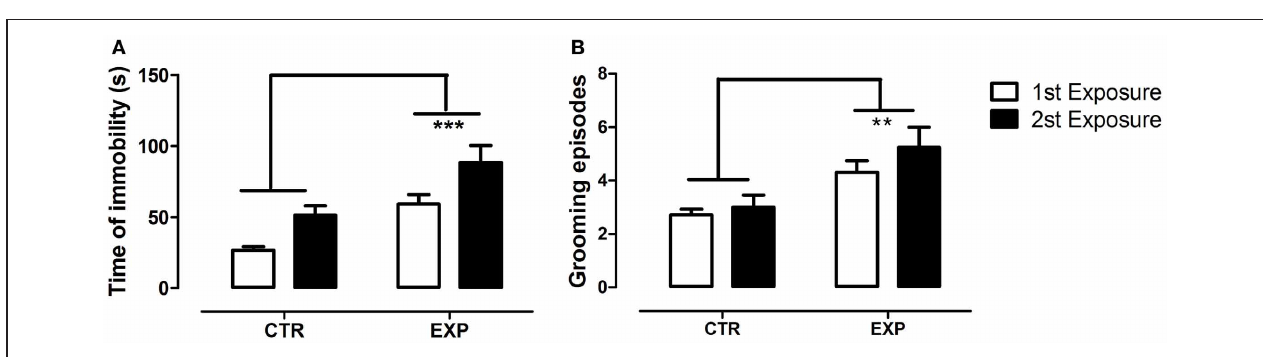
FIGURE 6 | Time of immobility (A) and number of grooming episodes (B) are shown as mean ± standard error. Control group (CTR) n = 14 and Experimental group (EXP), n = 16. The